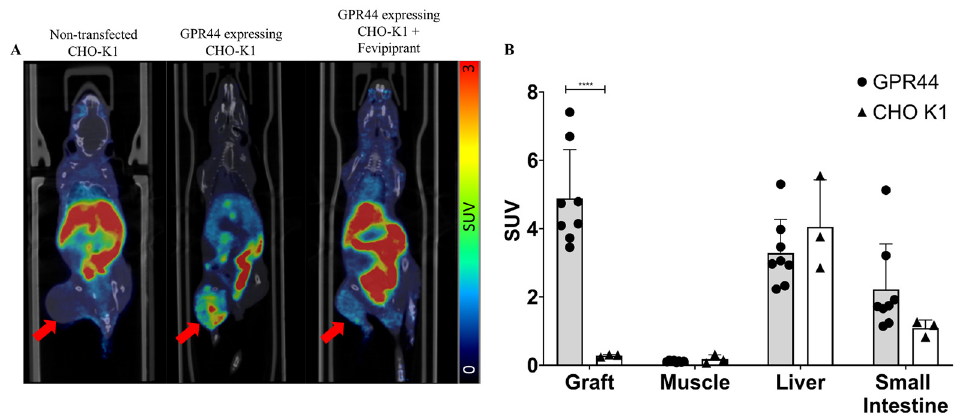
Figure 9. ( A ) Coronal view of fused PET/CT scan with the averaged signal of [ 18 F]MK-7246 from a static scan between 60–90 min post-injection. Red arrow indicates the site of the developed tumor. ( B ) Endpoint biodistribution of [ 18 F]MK-7246 in mice with tumors induced from non-transfected CHO-K1 (n = 3) or CHO-K1-expressing GPR44 (n = 8). Uptake of [ 18 F]MK-7246 was significantly higher in the tumors developed from CHO-K1-expressing GPR44 (**** p < 0.0001).